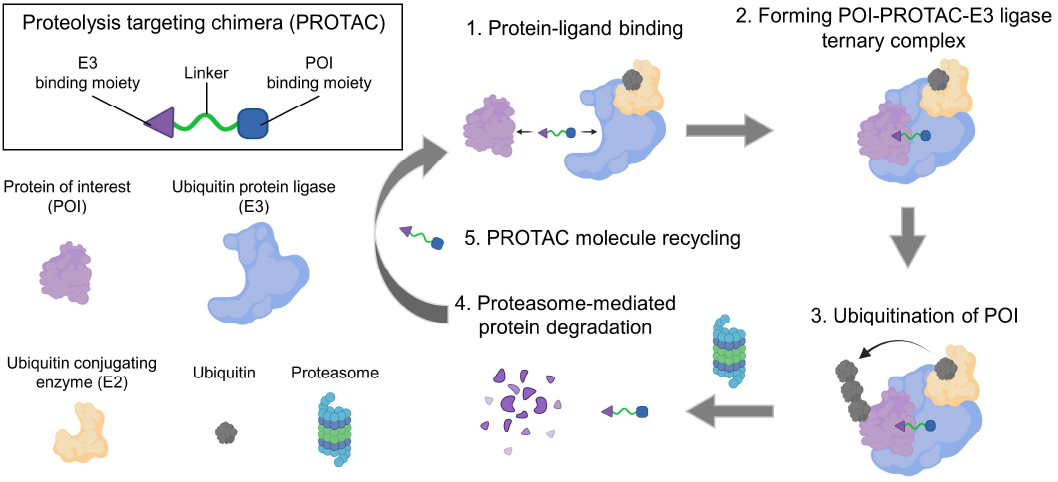
Figure 1. Schematic illustration of the mechanism of PROTAC. Firstly, the PROTAC molecule binds with POI and E3 ligase using the functional groups in its two ends. Then, the PROTAC molecule joins these two proteins together, forming a complex consisting of POI, PROTAC, and E3 ligase. The proximity of POI to the E3 ligase enables the ubiquitination of POI. Subsequently, the ubiquitin- tagged protein is recognized and degraded by the proteasome, and the PROTAC molecule can be reused to connect the next POI and E3 ligase.